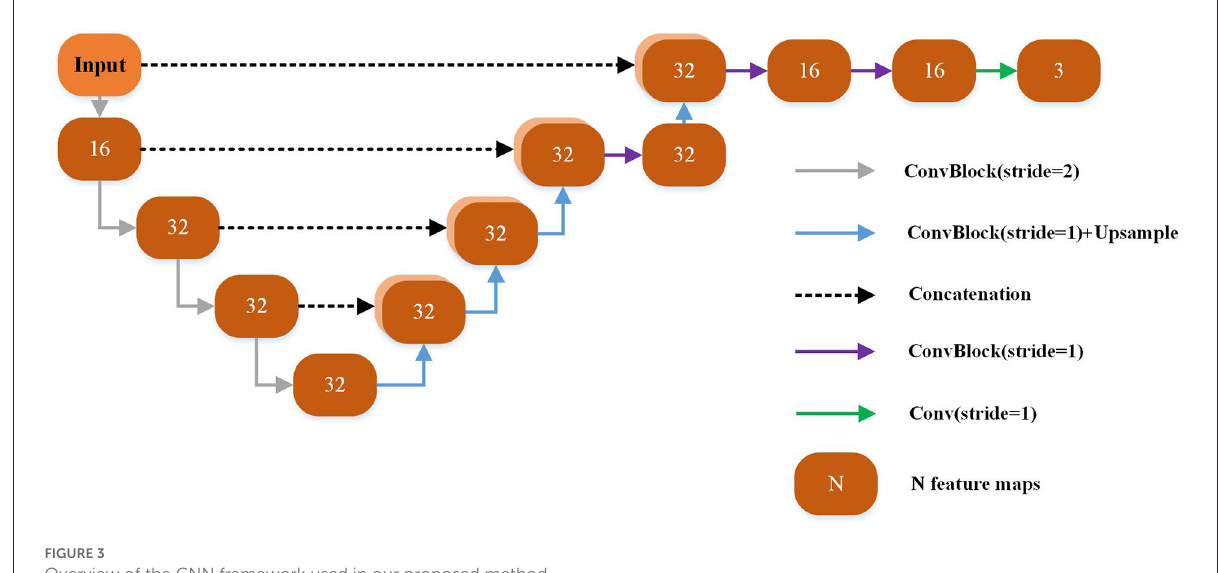
FIGURE3 Overview of the CNN framework used in our proposed